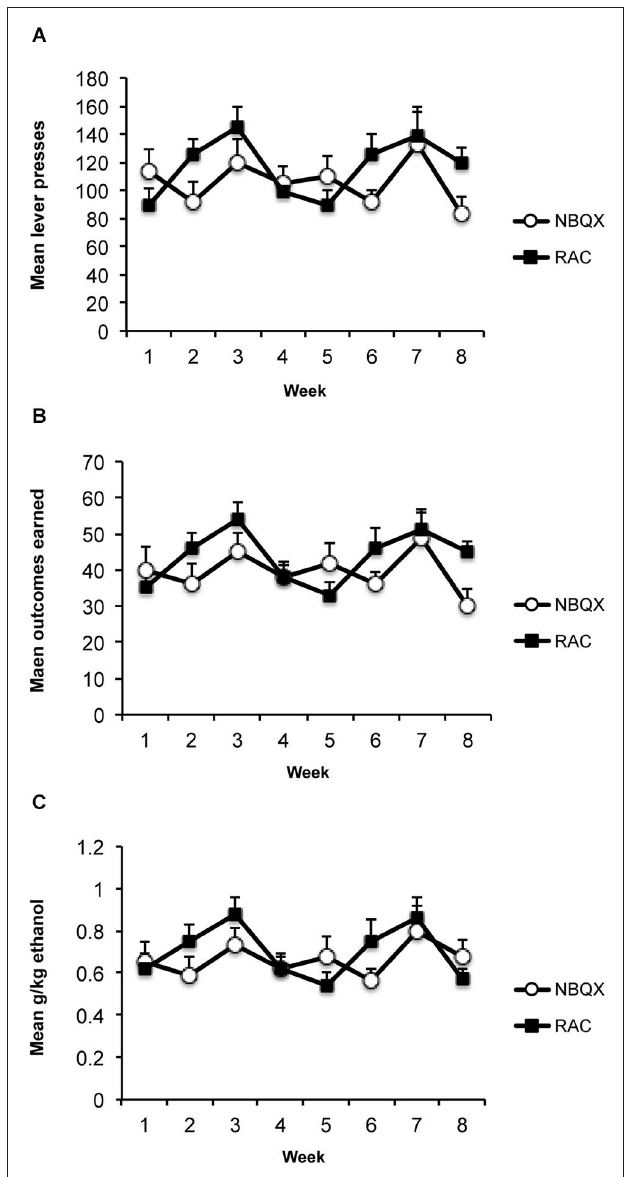
FIGURE 2 | Training data . (A) Mean (+/ − SEM) lever presses, (B) outcomes earned, and (C) g/kg alcohol across weeks of instrumental training prior to devaluation testing.